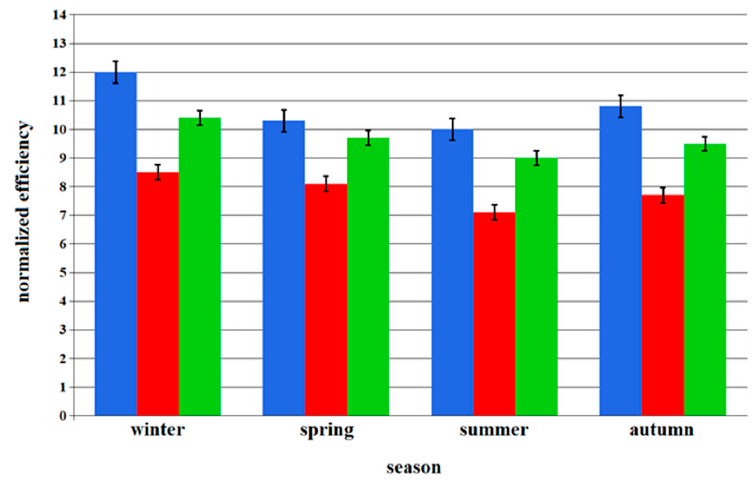
Figure 4. Average efficiency in year 2019 for different PV modules: ( █ ) MWG-30, ( █ ) AP-7105, ( █ ) STP-085. Standard error of the mean is illustrated as a black bar for each value column.